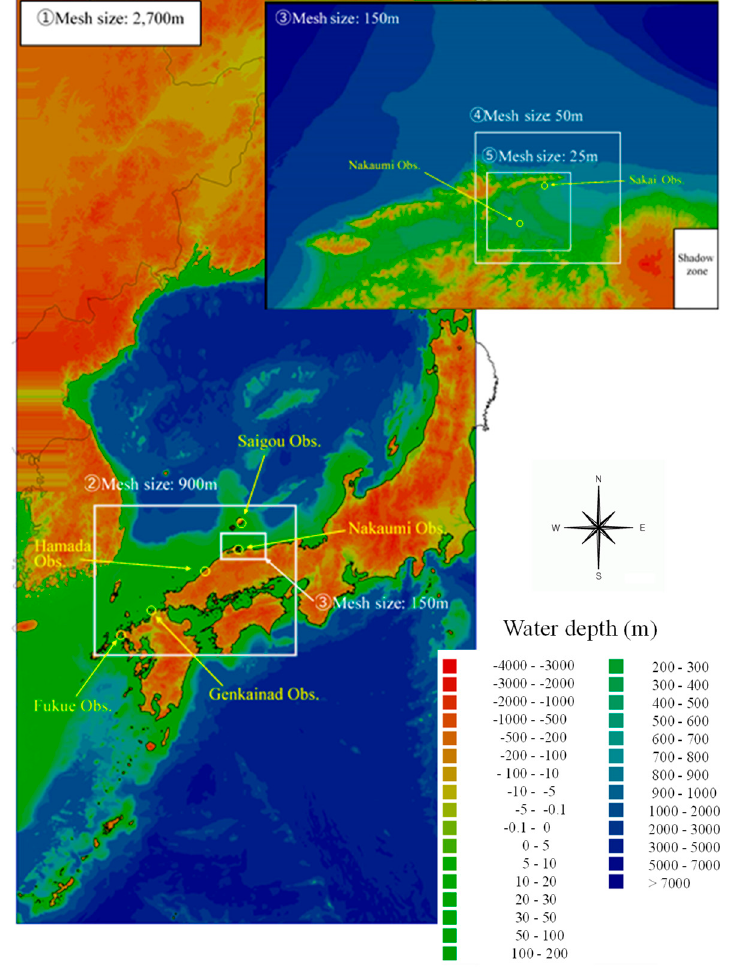
Figure 5. Computation domain with observation stations.